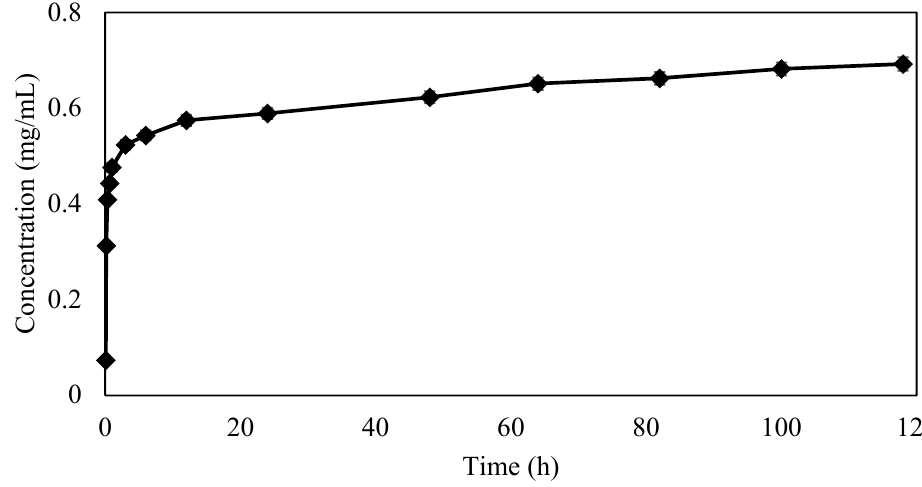
Figure 9. Cumulative concentration (mg/mL) of GS released from HNTs.